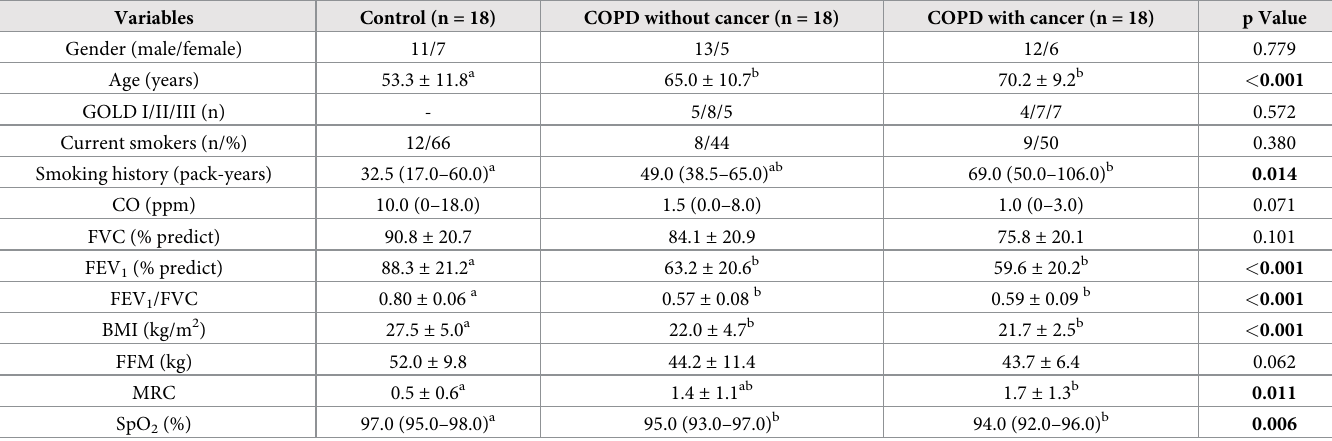
Table 1. General characteristics of patients in the study.